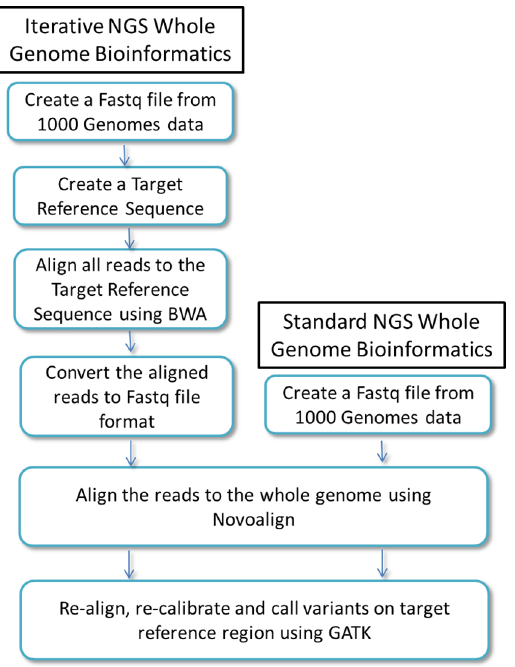
Figure 1. Basic components of the iterative workflow as compared to a standard NGS whole genome